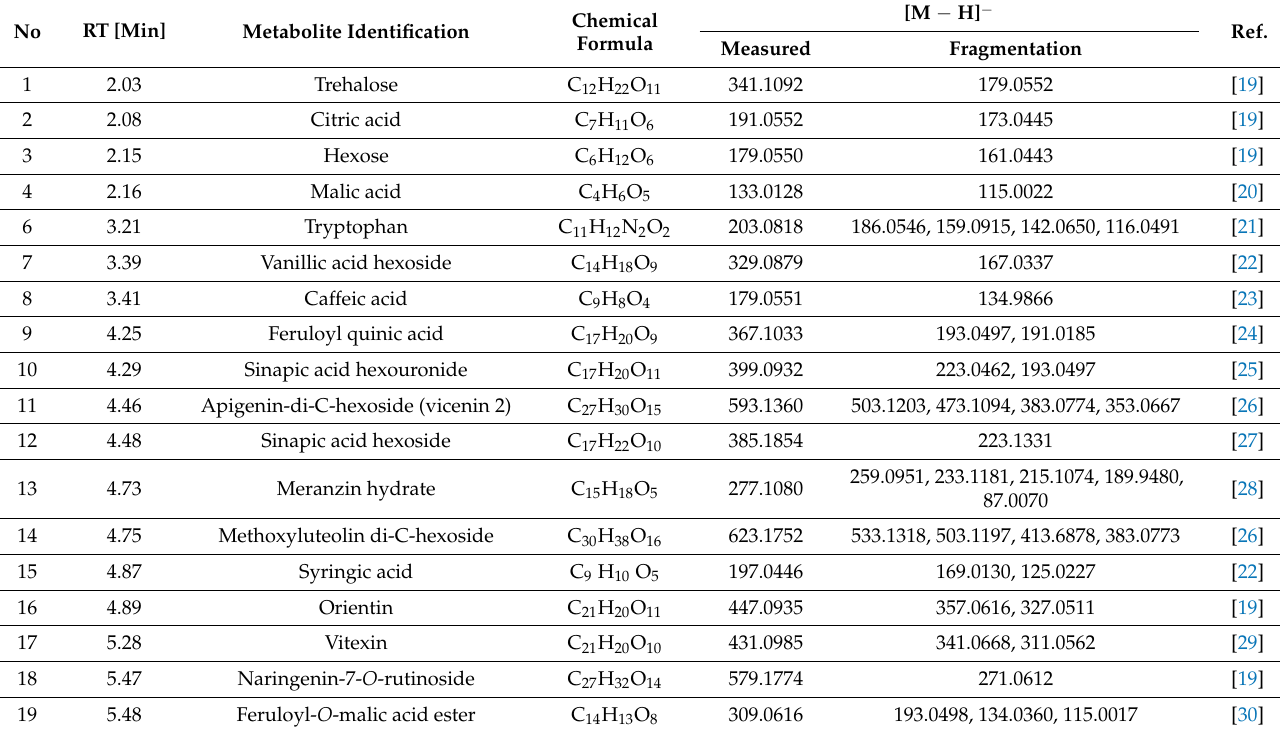
Figure 2. UPLC/MS/MS of mandarin ethanol extract (base peak) chromatogram. Table 2. UPLC/MS/MS of mandarin peels.